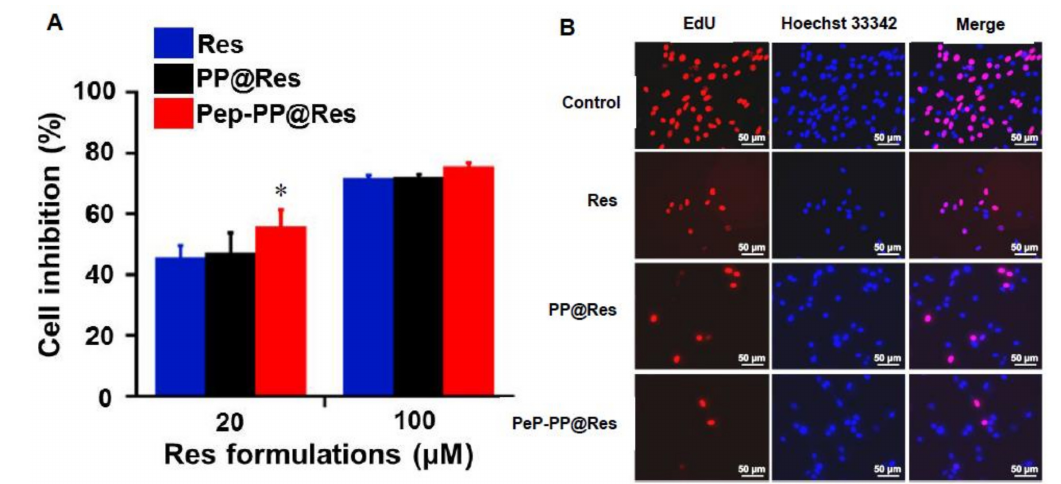
Figure 4. Growth-suppressive effects of the Pep-PP@Res nanoparticles on the C6 cells. ( A ) The cell proliferation assay showed distinct cell inhibition of the C6 cells after three repeats of short-term (4 h) treatments with the three Res formulations. Note: * indicates p -values < 0.05 when compared with Res and PP@Res. ( B ) Reduction of EdU-labeling frequencies in the C6 populations treated with Res, PP@Res and Pep-PP@Res. Red signals, EdU-labeled nuclei of proliferating cells; blue signal, Hoechst-labeled nuclei of total cells; merged pink signals, the nuclei of proliferating cells.